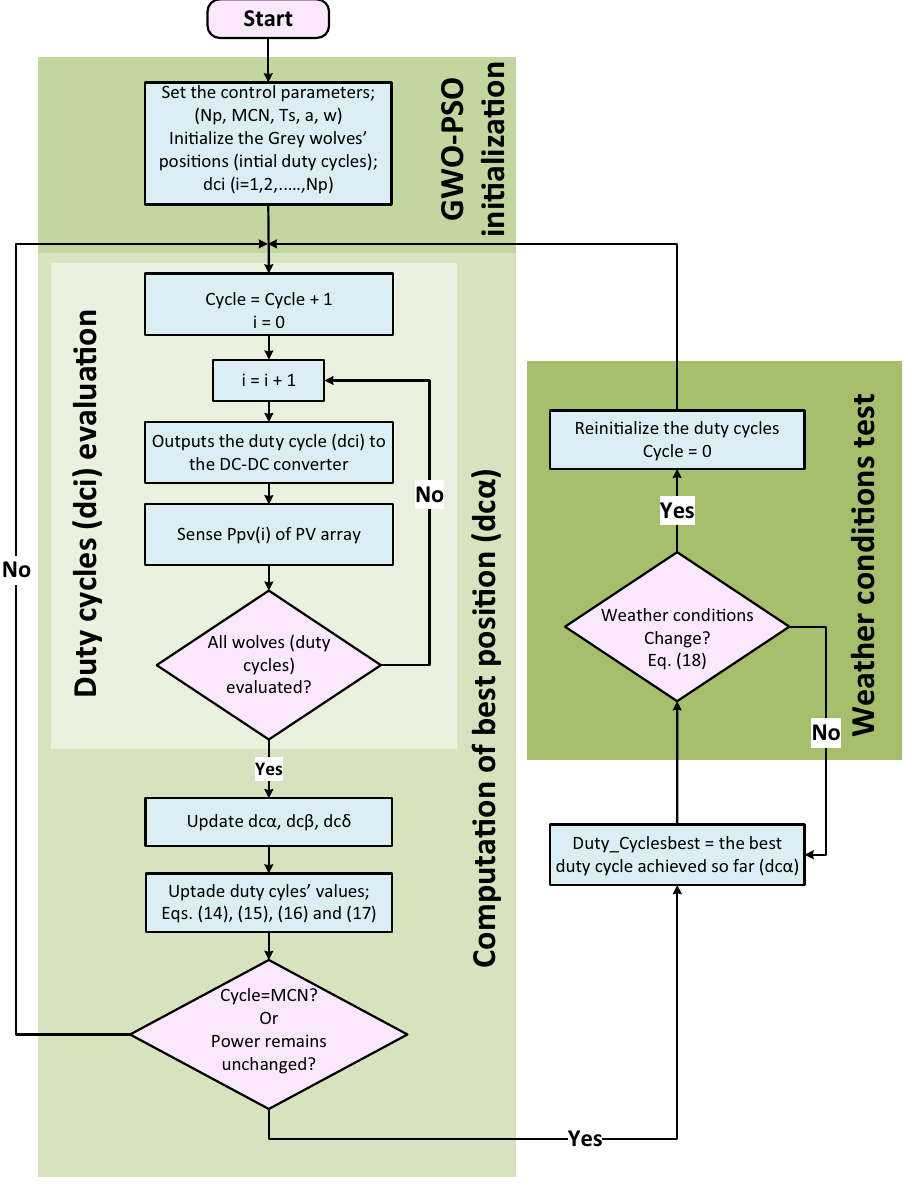
Figure 6. Flowchart of the proposed GWO–PSO based